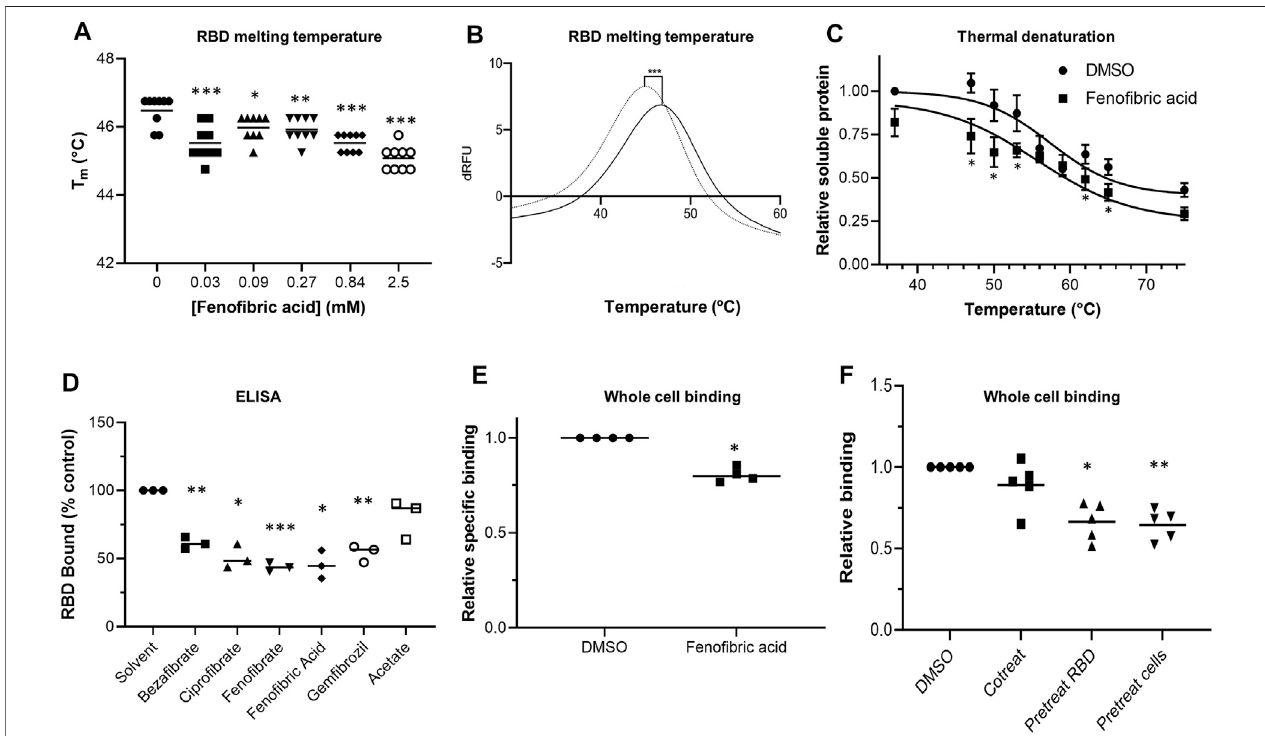
FIGURE 2 | Effect of feno fi brate on RBD and RBD binding to ACE2 A. Differential scanning fl uorimetry (DSF). T m of 1 μ g RBD alone or with increasing concentrations of feno fi bric acid. The results (mean ± SD, n (cid:2) 3) were signi fi cantly different from RBD where shown (*** p < 0.001; ** p < 0.01; * p < 0.05; paired t -test). B. The fi rst differential of the thermal stability of 1 μ g RBD alone (solid line) or with 2.5 mM feno fi bric acid (dotted line). A direct interaction of feno fi bric acid with SYPRO ™ Orangedye(intheabsenceofRBD)wasnotobserved. C. CellculturesupernatantcontainingHiBIT-RBDwasincubatedattheindicatedtemperaturefor7 minand cleared by centrifugation, and the soluble RBD was measured by addition of HiBIT detection reagent. The samples also contained 0.05% DMSO or 230 µM feno fi bric acid and are signi fi cantly different where shown (* p < 0.05). The results (mean ± SD, n (cid:2) 4) are expressed as a fraction of the soluble RBD measured in the absence of drug. D .ELISAtomeasureinhibitionofRBDbindingtoACE2by fi brates.BiotinylatedACE2wascapturedontoahighbindingmicroplatecoatedwithstreptavidinpriorto the addition of RBD preincubated with or without 230 µM beza fi brate, cipro fi brate, feno fi brate, feno fi bric acid, gem fi brozil, or acetate control. Data (mean ± SD, n (cid:2) 3) represented % no inhibitor control and are signi fi cantly different from this where shown (* p < 0.05; ** p < 0.01; *** p < 0.005). E . A whole cell-binding assay to measure inhibitionofRBDbindingtoACE2.COScellsweretransfectedwithACE2andincubatedonicewithHiBIT-tagged SARS-CoV-2RBDandtheindicated fi brate(230 µM). After washing, the bound RBD was measured by the addition of LgBIT and NanoLuc substrate. Nonspeci fi c binding was measured in cells not expressing ACE2 and subtracted from the total binding to determine speci fi c binding. The results mean ± SD, n (cid:2) 4) were normalized to the binding measured in cells exposed to DMSO and are signi fi cantly different where shown (* p < 0.005). F . HiBIT-RBD or COS cells expressing ACE2 were preincubated (37 ° C) with feno fi bric acid (230 µM) before mixing andmeasuringbindingafterafurther20 min.Nonspeci fi cbindingwasmeasuredasdescribed above.Theresults(mean ± SD,n (cid:2) 5)aresigni fi cantlydifferent(* p < 0.05; ** p < 0.01) from the speci fi c binding measured in cells in which HBIT-RBD and feno fi brate were added simultaneously to the